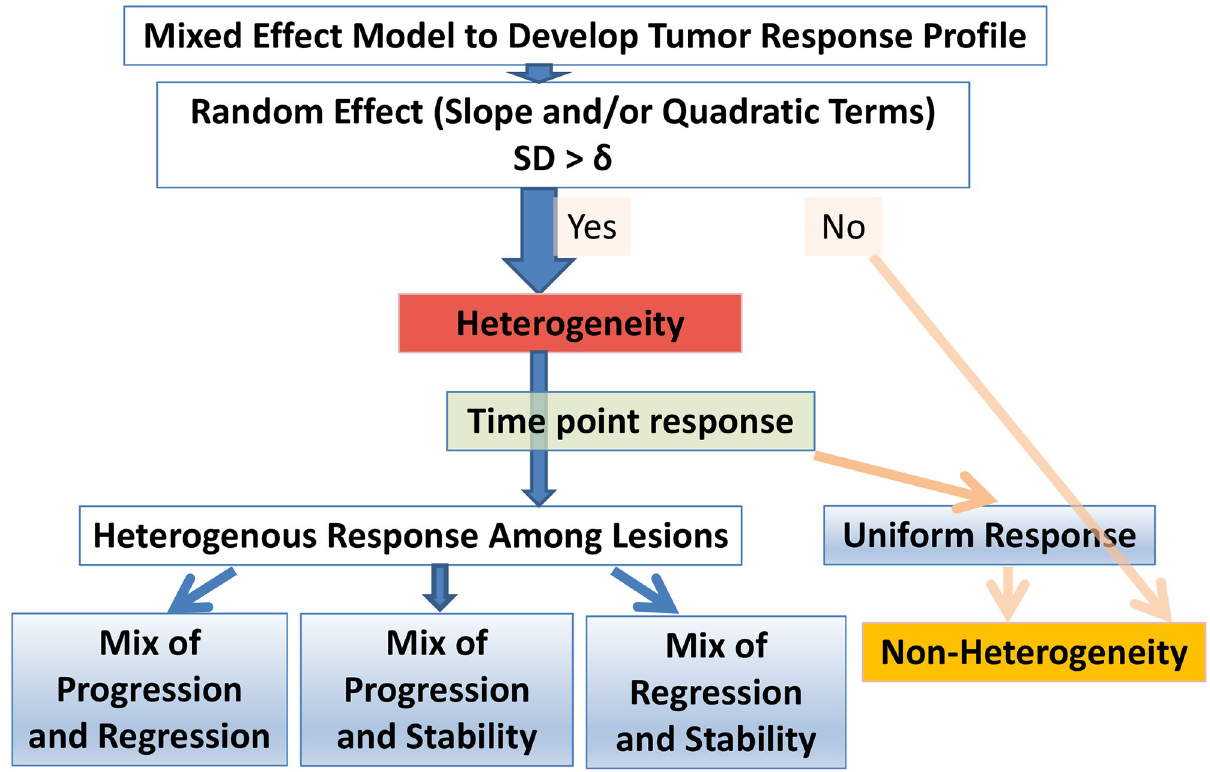
Fig 3. LeHeC algorithm.